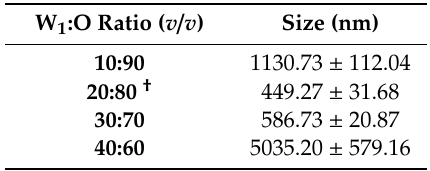
Table 2. E ff ect of W 1 :O ratio ( v / v ) on droplet size of double emulsion (at 25 ◦ C, n = 3, mean ± SD). W 1 :O Ratio ( v / v ) Size (nm) 10:90